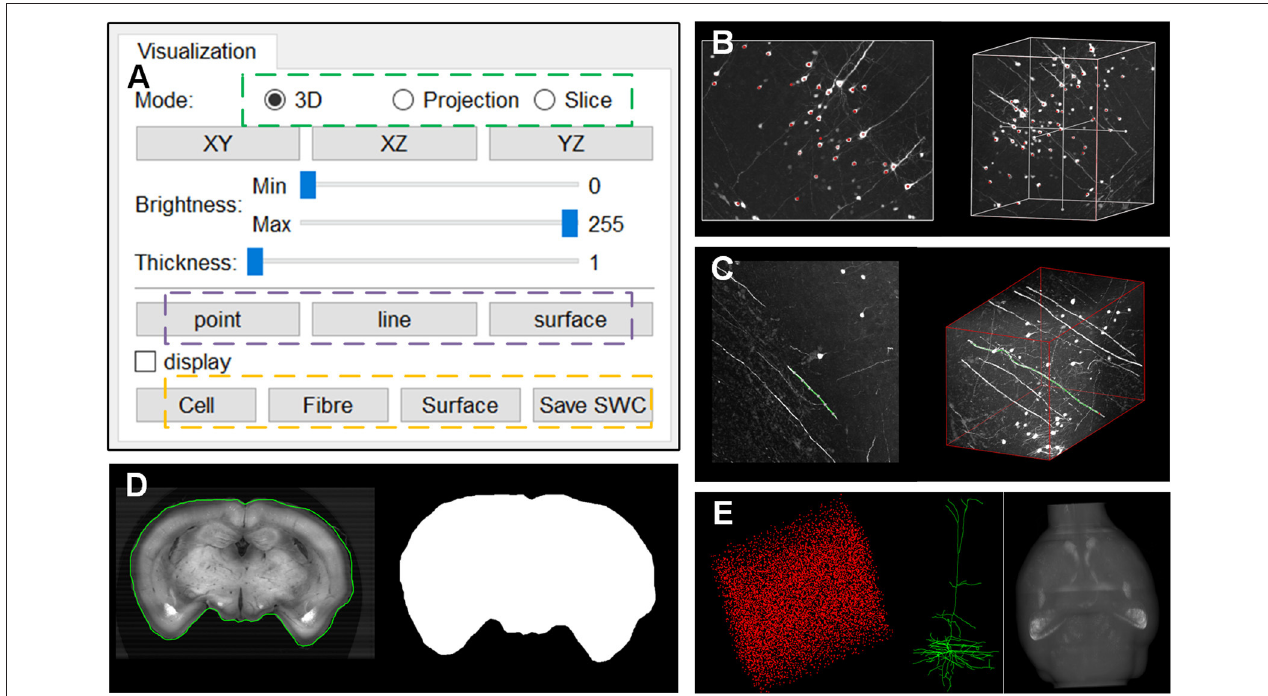
FIGURE 8 | The webTDat interface for data annotation: (A) The control panel for activating the annotation functions; (B) Annotation of somas in “point” mode in the MIP view; (C) Annotation of neuron fibers in “line” mode in the MIP view; (D) Annotation of brain contour in “surface” mode in the slice view; (E) Visualizations of the three types of annotation results, namely, soma, neuron, and brain contour.